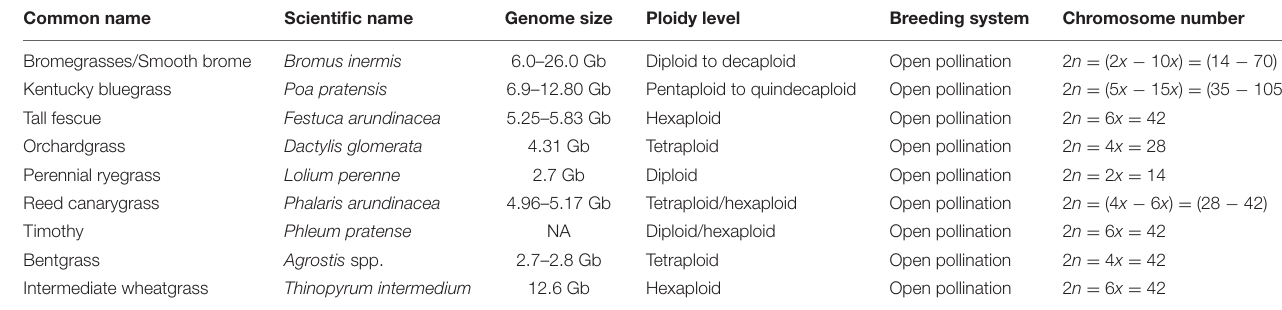
TABLE 1 | Name, genome information, and breeding behavior of commonly used cool-season C3 perennial